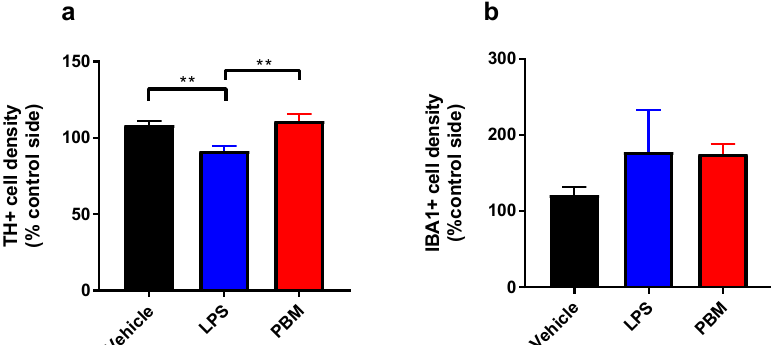
Figure 2. The e ff ects of 10 µ g lipopolysaccharide (LPS) and PBM treatment on TH + and IBA1 + cell densities in the substantia nigra pars compacta (SNc). ( a ) TH + cell density was significantly reduced Figure 2. The effects of 10 µg lipopolysaccharide (LPS) and PBM treatment on TH+ and IBA1+ cell from vehicle levels in LPS rats (** p < 0.01) and between LPS and PBM rats (** p < 0.01). ( b ) There densities in the substantia nigra pars compacta (SNc). ( a ) TH+ cell density was significantly reduced were no significant di ff erences between groups in IBA1 + cell density. Analyses were conducted with one-way ANOVA with Tukey multiple comparisons test. Vehicle: n = 8; LPS: n = 4; PBM: n = 4. Values represent means ± represent means ± SEM.